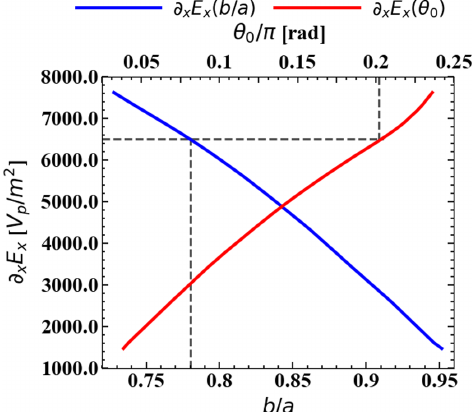
= ∂ x x =m 2 where V is the voltage on p p 50 Ω is constant c; geom ¼